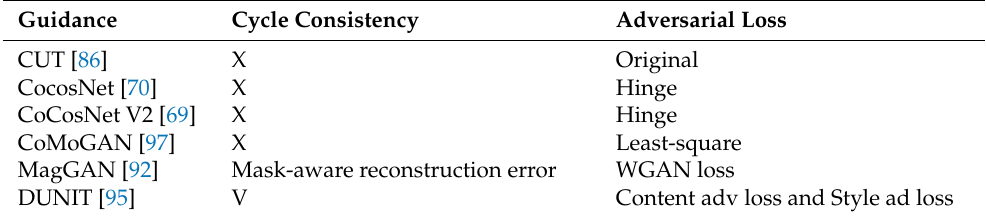
Table 8. Comparison between papers in the Guidance category (Section 9). This comparison is based on the use of the cycle consistency and the type of adversarial loss used. “V” and “X” means that the method use the technique in the columns is “used” and “not used” respectively. “-” indicates that the corresponding information has not been